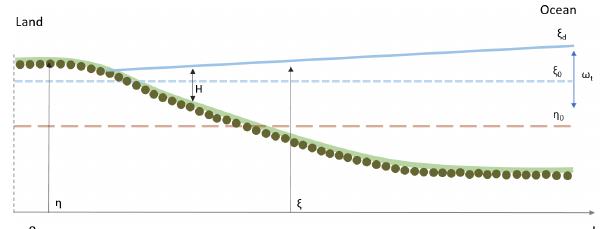
Figure 1. Schematic representation of the model geometry. The ξ and η are the water surface elevation and channel bed elevation. At the beginning of the simulation the bed is assumed horizontal ( η 0 ), the water depth is H and the mean water surface elevation is ξ 0 . ω t represents the tidal amplitude, and the water surface elevation at the ocean boundary ( x = L ) is ξ d